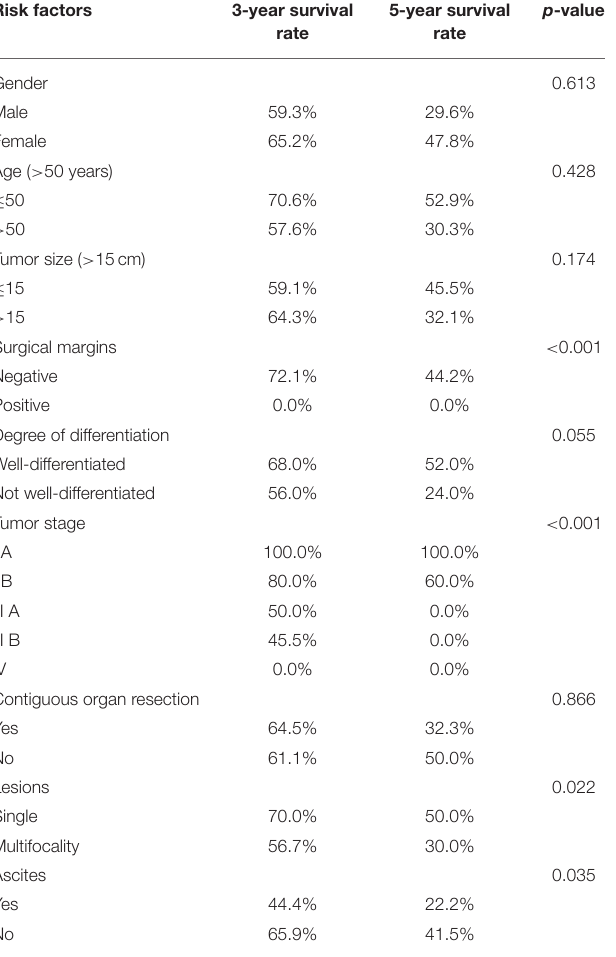
TABLE 4 | Risk factors for progression-free survival after operation ( p -values of the tarone-ware test are presented).